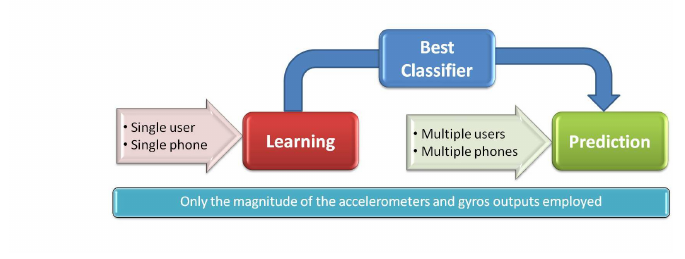
Figure 2. Research